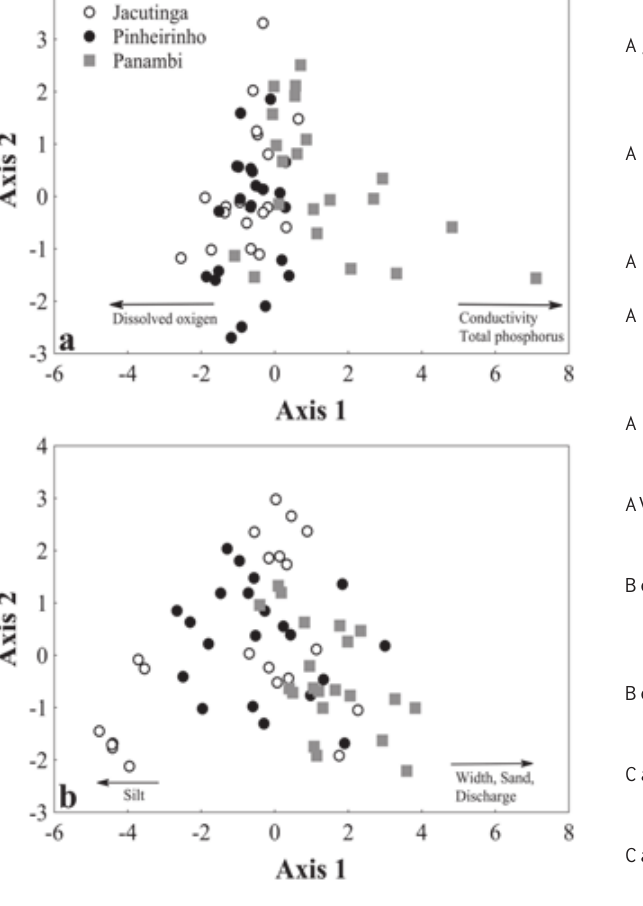
Fig. 3. Principal component analysis (PCA; Axis 1 x Axis 2)